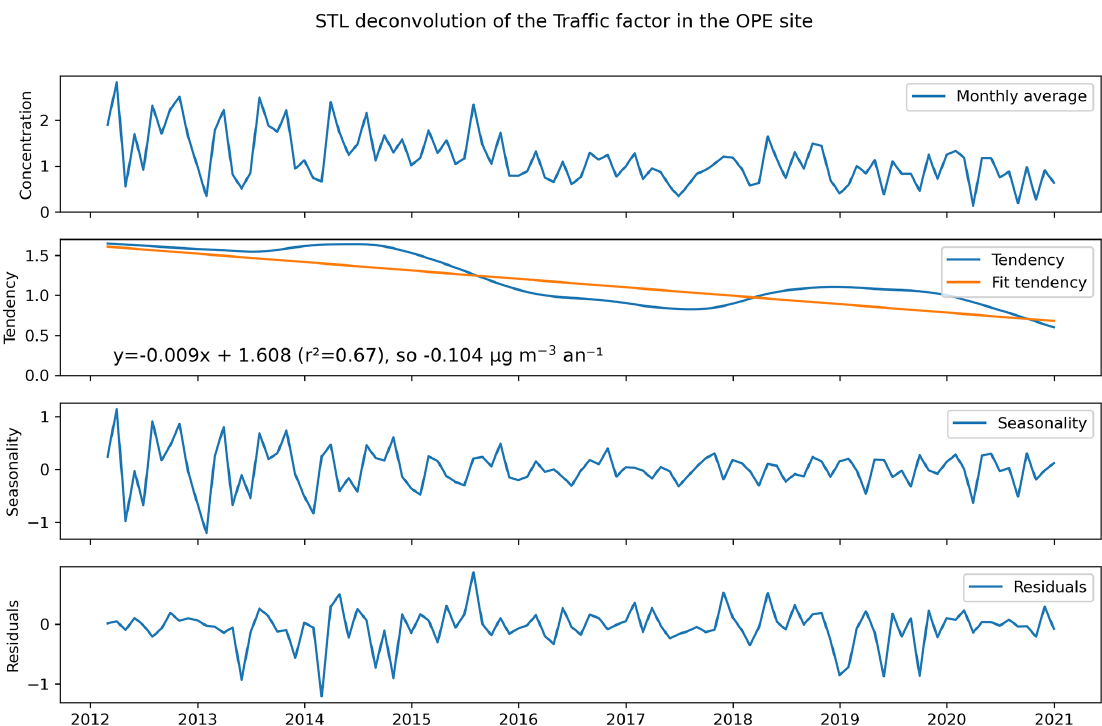
Figure 6. The season-trend (STL) deconvolution of contributions (in µgm − 3 ) from the traffic factor to PM 10 from the year 2012 to 2020.